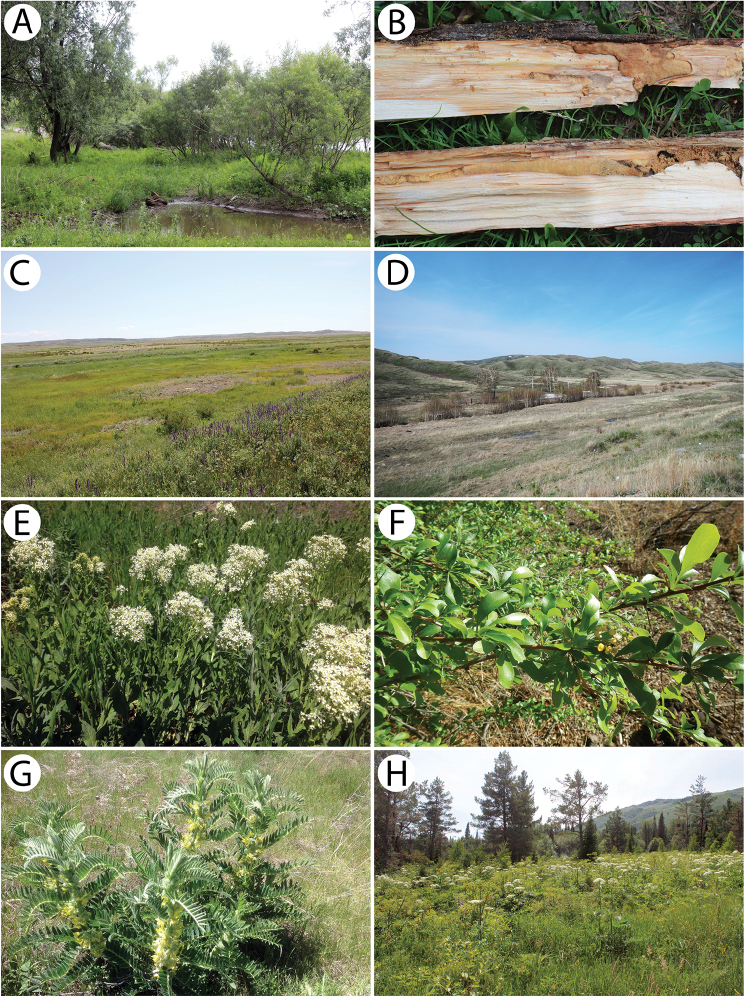
Field photos of host plants, larval feeding galleries and habitats of typical Kazakh cerambycid species: A river bank overgrown by willows, the habitat of XylotrechusadspersusB larval feeding gallery of X.adspersus in a branch of Salix sp. C roadside vegetation strip in Taskesken environs, the habitat of XylotrechusalakolensisD hilly grove with birches, the habitat of XylotrechushircusE inflorescences of Lepidiumdraba, the food plant of CleroclytussemirufuscollarisFBerberisvulgaris, the host plant of C.semirufuscollarisGAstragalussieversianus, possible host plant of AgapanthiaviolaceaH roadside strip with herbaceous vegetation, the habitat of Agapanthiaalternansalternans.